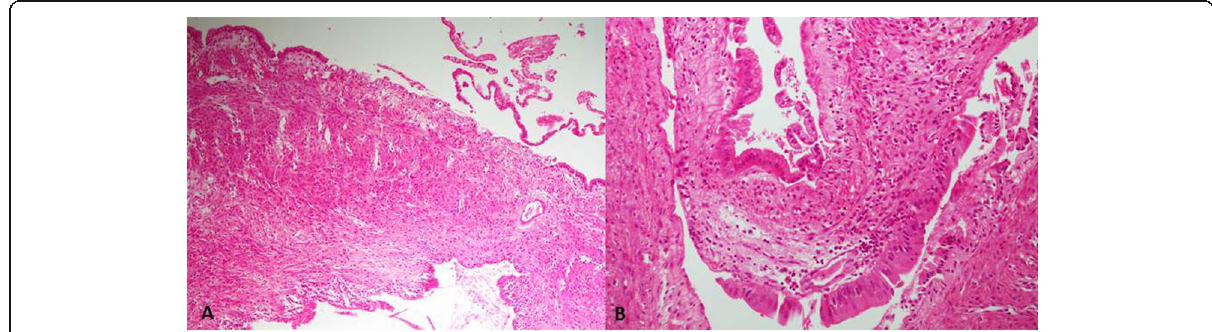
Fig. 5 a , b Lining epithelial denudation with focal inflammation ( a ), acute and chronic inflammation within cyst wall ( b